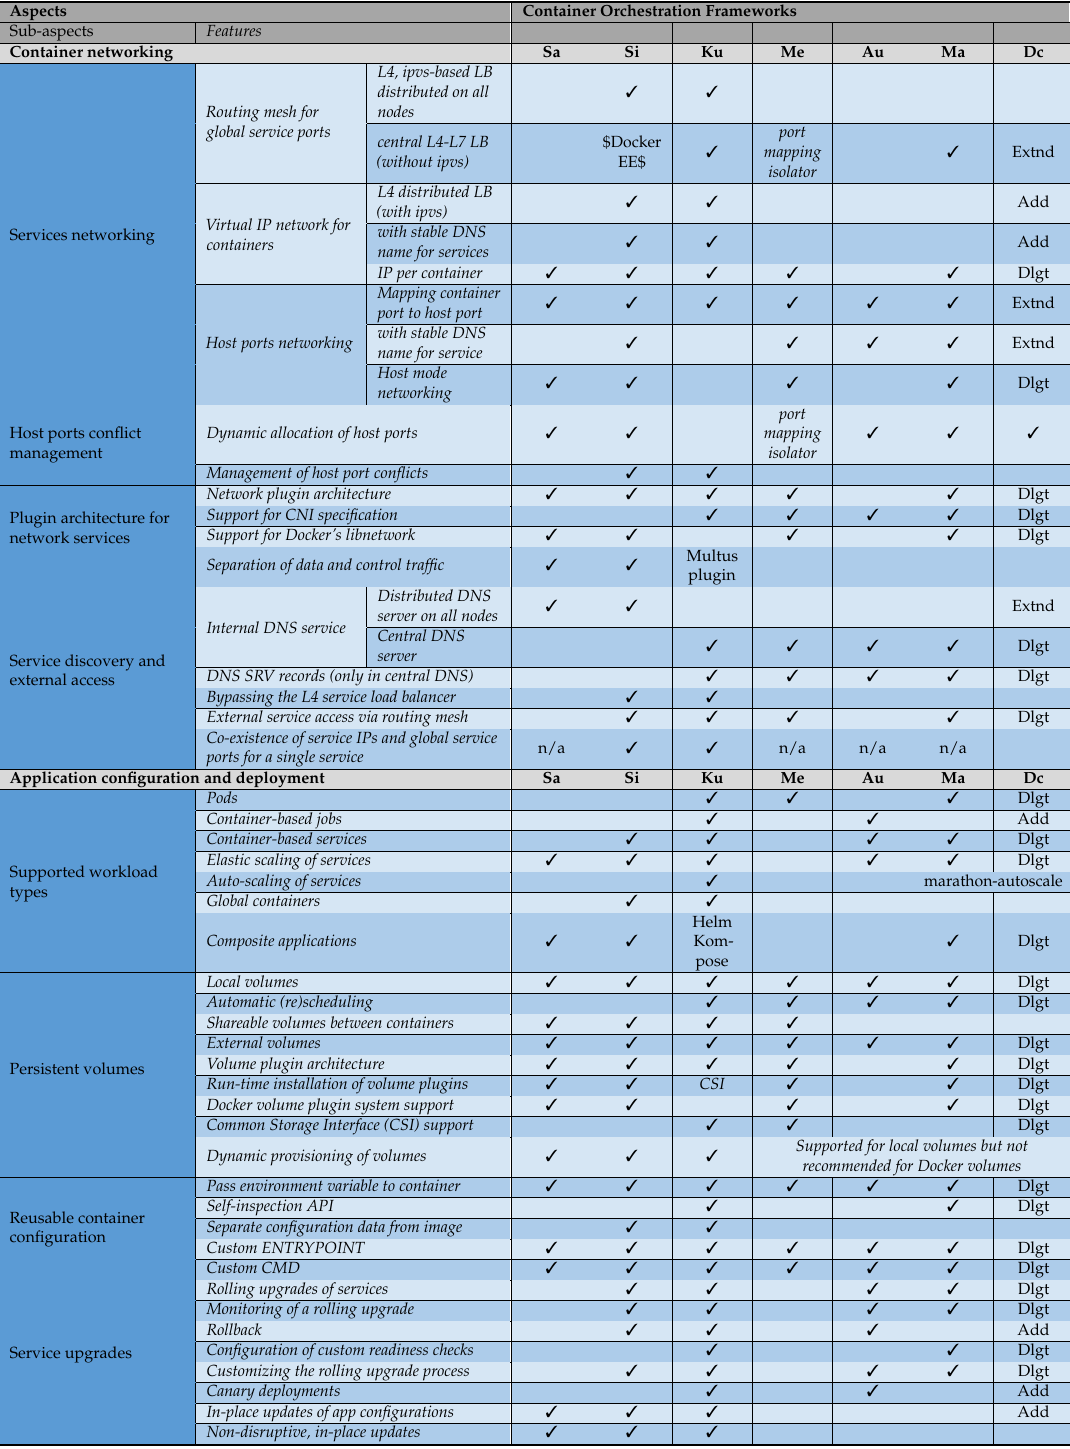
Sub-aspects Features Container networking